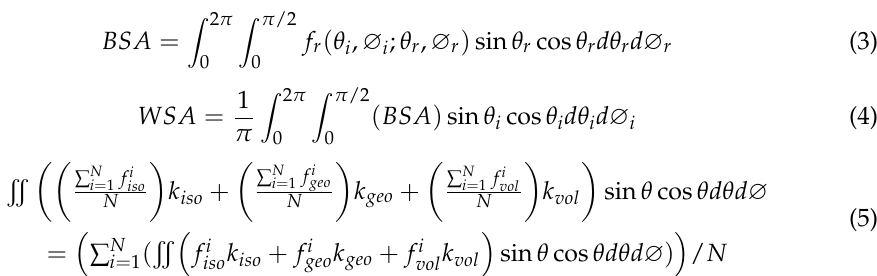
Figure 3. Diagram of smoothing BRDF/Albedo in multi-spatiotemporal scales. ( a ) Smoothing in temporal scales; ( b ) Smoothing in spatial scales.